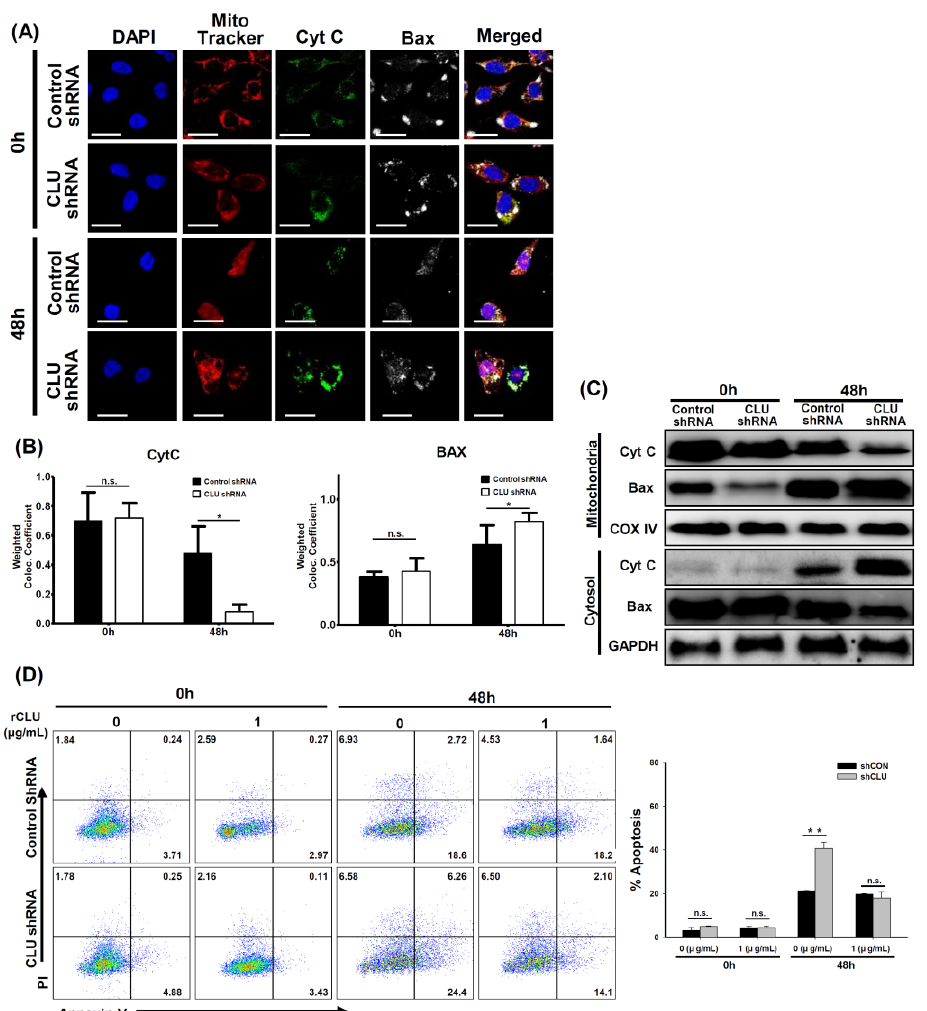
Figure 4. Clusterin (CLU) regulates the levels of Bax and cytochrome c and apoptosis. Wild-type (WT) and CLU-deficient (CLU − / − ) mice were exposed to >95% O 2 for 48 h. ( A ) Immunofluorescence experiments were conducted. Double staining against MitoTracker (red)/cytochrome c (Cyt C) (green) and MitoTracker (red)/Bax (white) is shown. ( B ) Mean intensity of co-localization with MitoTracker (Red) was calculated using the ZEN software. ( C ) Protein expression of Bax and Cyt C in both cytosolic and mitochondrial fractions was observed by Western blotting. ( D ) Cells were cultured in 95% O 2 and 5% CO 2 with recombinant CLU (rCLU) for up to 48 h. Cellular apoptosis was assayed by annexin V and PI counterstaining and analyzed with flow cytometry. Scale bars in ( A ); 20 µ m, n.s. = not significant; * p < 0.05, ** p < 0.01.